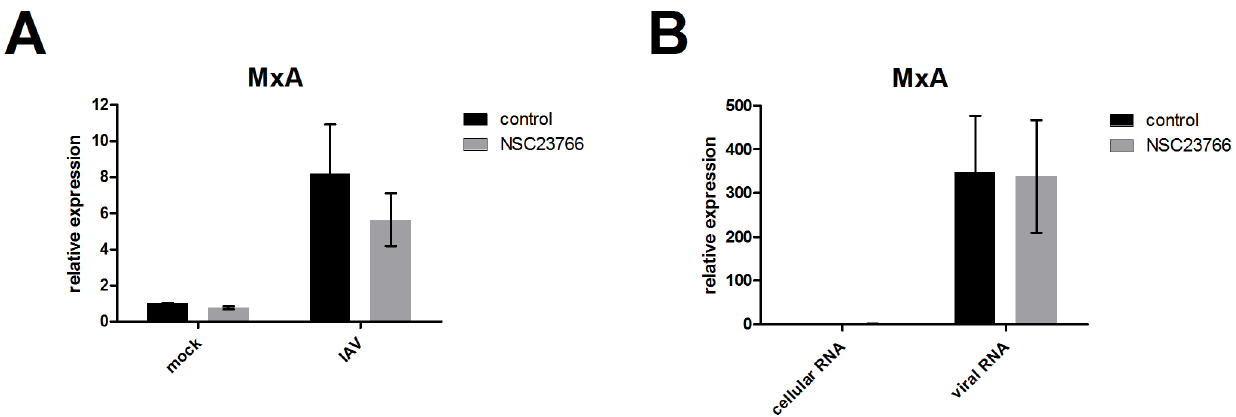
Figure 7. NSC23766 treatment does not directly affect expression of the interferon b regulated gene mxa . (A) A549 cells were infected with A/Puerto-Rico/8/34 rec. (moi=5) and subsequently treated with NSC23766 (100 m M) 30 min after infection. (B) Alternatively, the cells were transfected with cellular or viral RNA (0.5 m g/12-well) in presence or absence of NSC23766 (100 m M). (A–B) After six hours of incubation, total RNA was isolated for qRT-PCR and the fold increase of mxa mRNA was determined using the housekeeping gene gapdh as the internal standard. Data represent means 6 SD of three independent experiments including three biological samples.